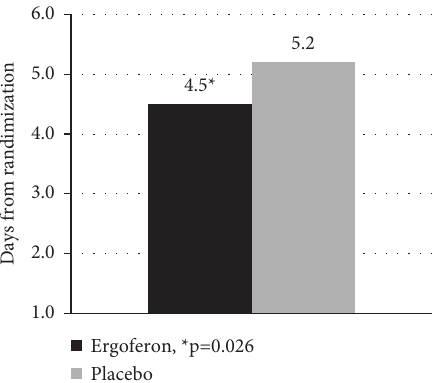
Figure 2: Time to alleviation of all ARI symptoms. The time to alleviation of all ARI symptoms in the Ergoferon group was sig- nificantly less compared to the placebo group.